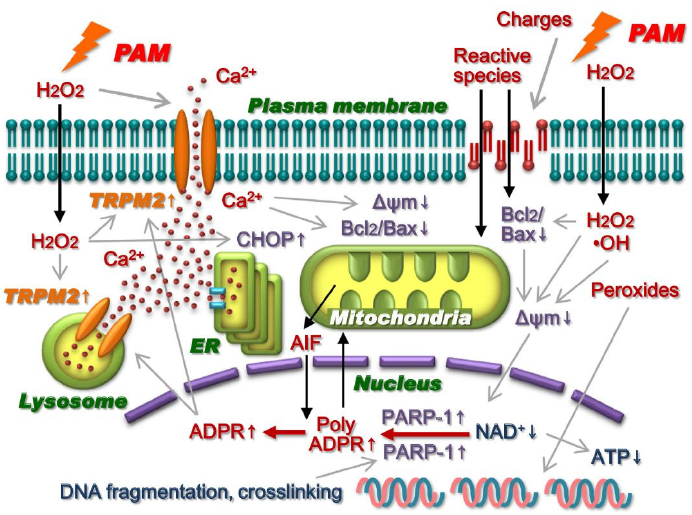
Figure 6. Intracellular molecular mechanisms of cell death in PTS-exposed (cell culture medium)